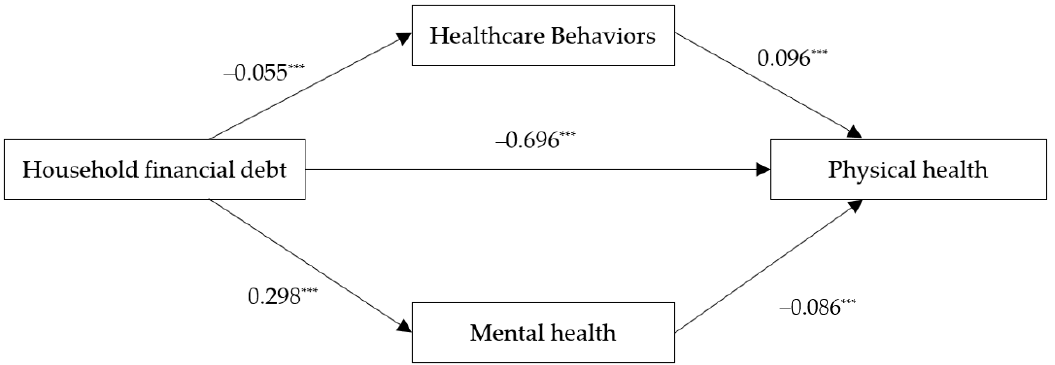
Figure 1. Pathway diagram of the effect of household financial debt on physical health. Note: *** p < 0.01.